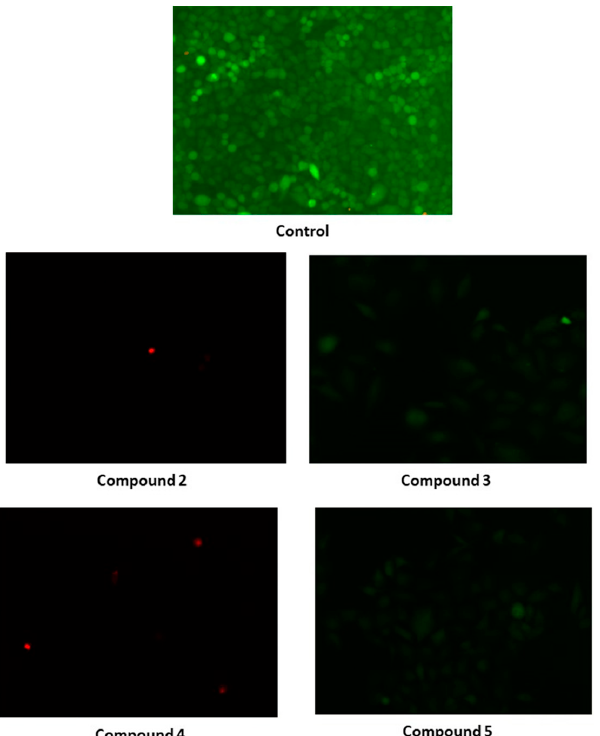
Figure 14. Morphological appearance of control, non-treated and HeLa cells treated with peptides 2 – 5 (500 μ M) photographed after staining with FDA and PI under the fluorescence microscopy. The use of FDA and PI fluorescent stain allows differentiation between living, ne- crotic, and apoptotic cells in the sample of treated cells. In a photograph of control HeLa cells, there are plenty of live, green-stained cells, whereas in the case of HeLa cells treated with compounds 2 and 4 , respectively, only a few dead cells stained red can be seen (Fig- ure 14). To further confirm and quantify the observed morphological changes indicative of the induction of cell death during treatment with the tested peptides 2 – 5, flow cytom- etry analysis was conducted using the Muse ® Cell Analyser and the Muse™ Annexin V & Dead Cell Kit. The results of this analysis for HeLa cells are shown in Figure 15.